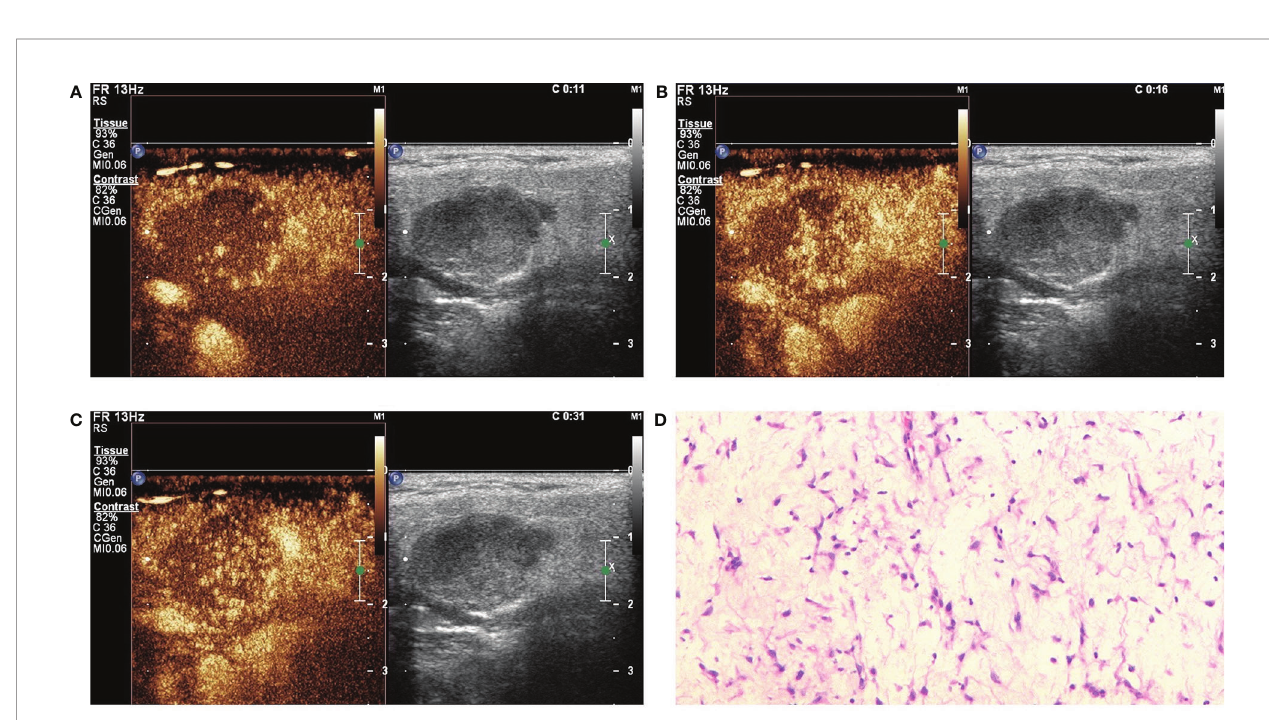
FIGURE 3 | Pleomorphic adenoma (PA) in contrast-enhanced ultrasound (CEUS). The qualitative CEUS showing the mass with low intensity and heterogeneous enhancement and echo-free areas. The perfusion pattern of contrast agent was “ slow in and fast out ” ( A -early phase; B -middle phase; C -late phase). (D) H&E stain (original magni fi cation